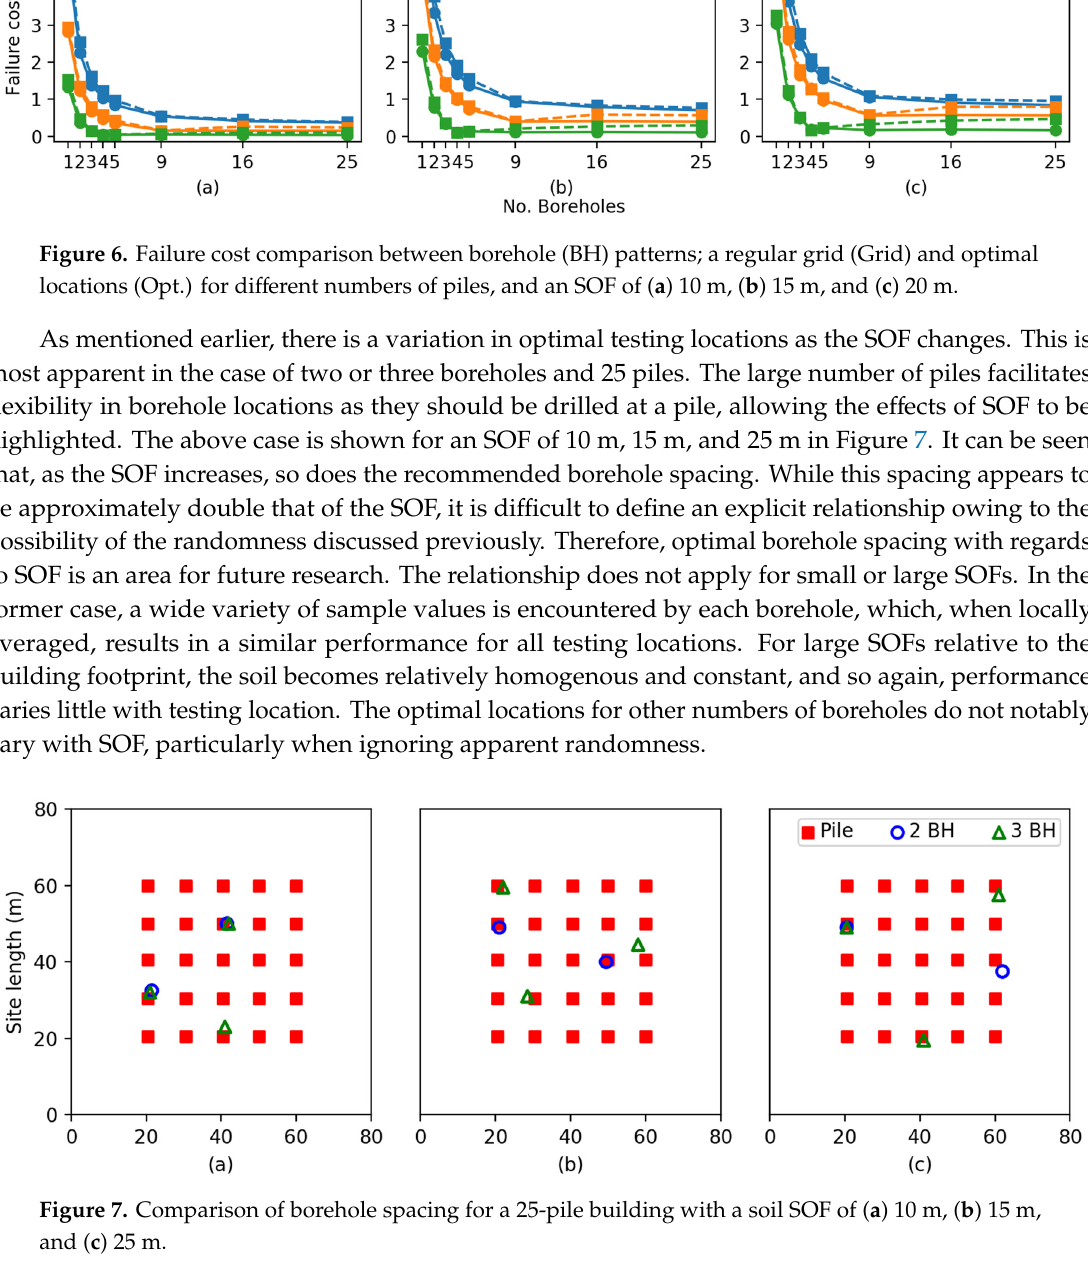
Figure 5. Optimal testing locations for different numbers of piles and boreholes for a soil with a COV of 80% and an SOF of 20 m.